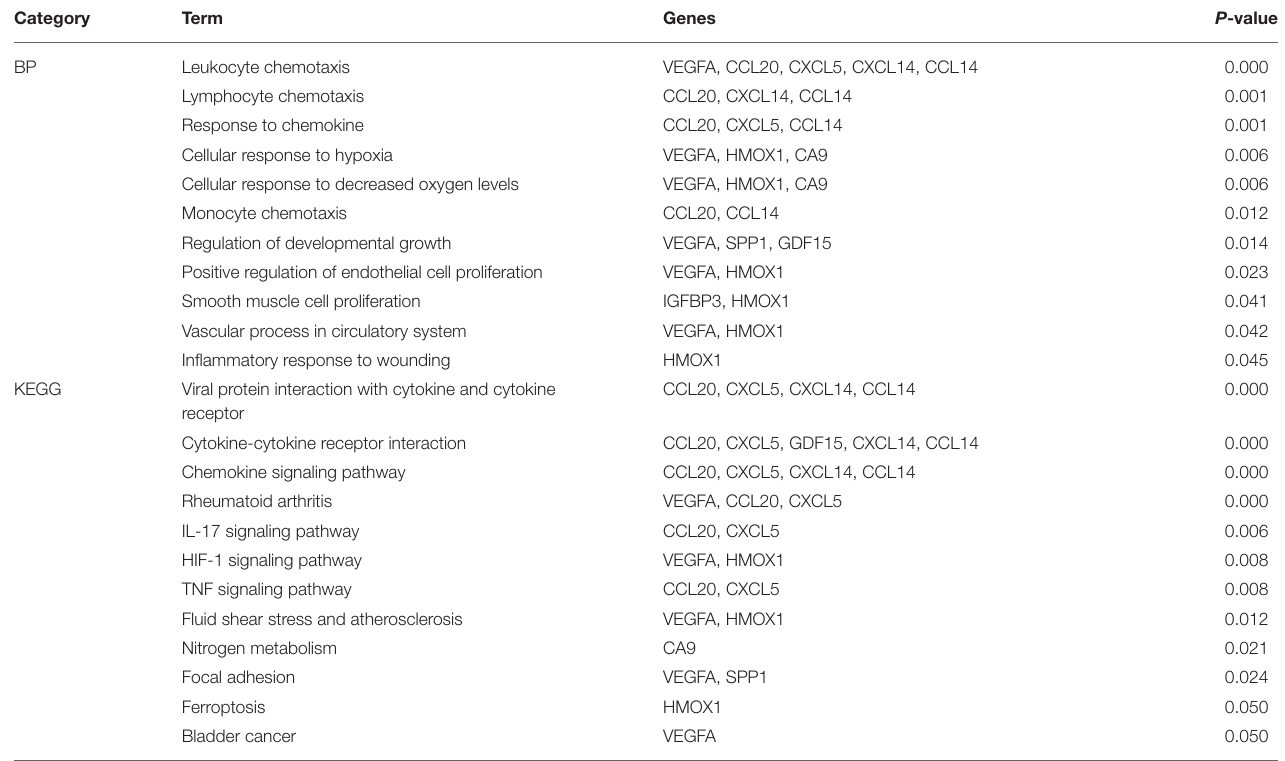
TABLE 1 | GO functional annotation and KEGG pathway enrichment analysis of hub genes.